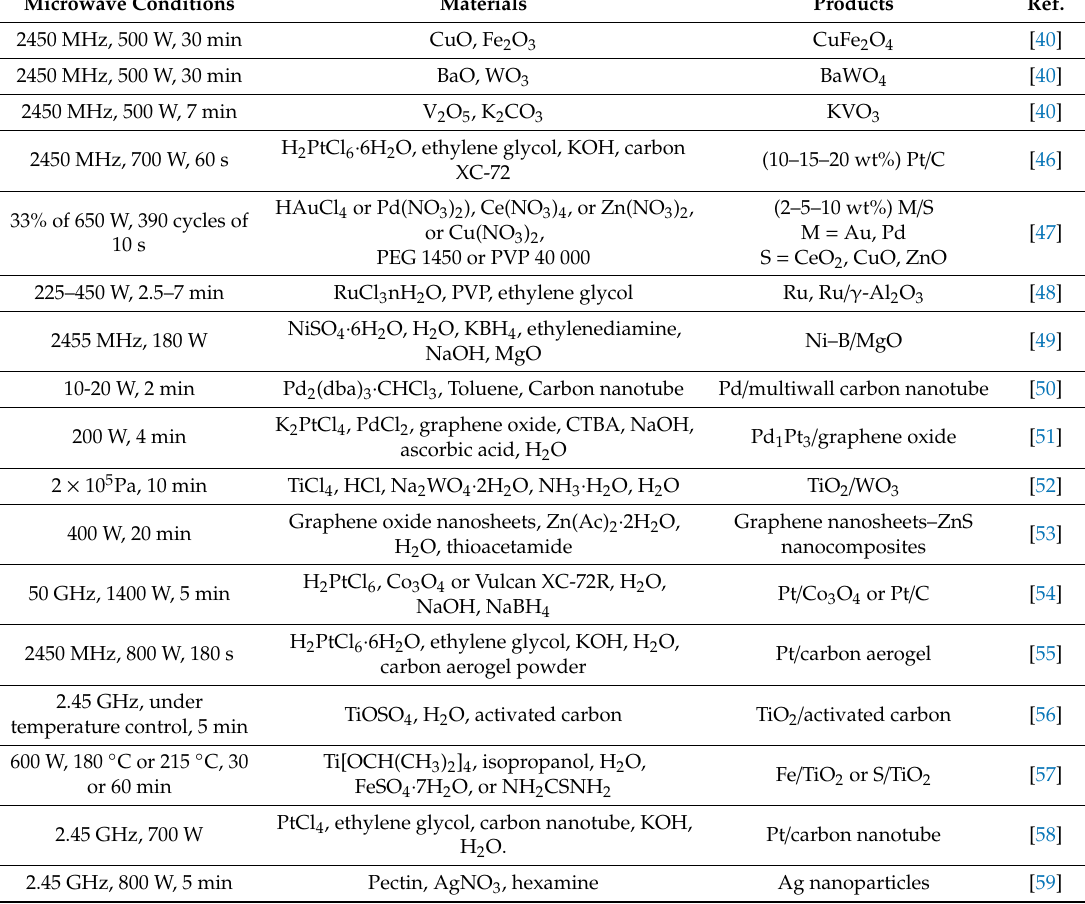
Table 1. Microwave preparations of heterogeneous catalysts: some relevant